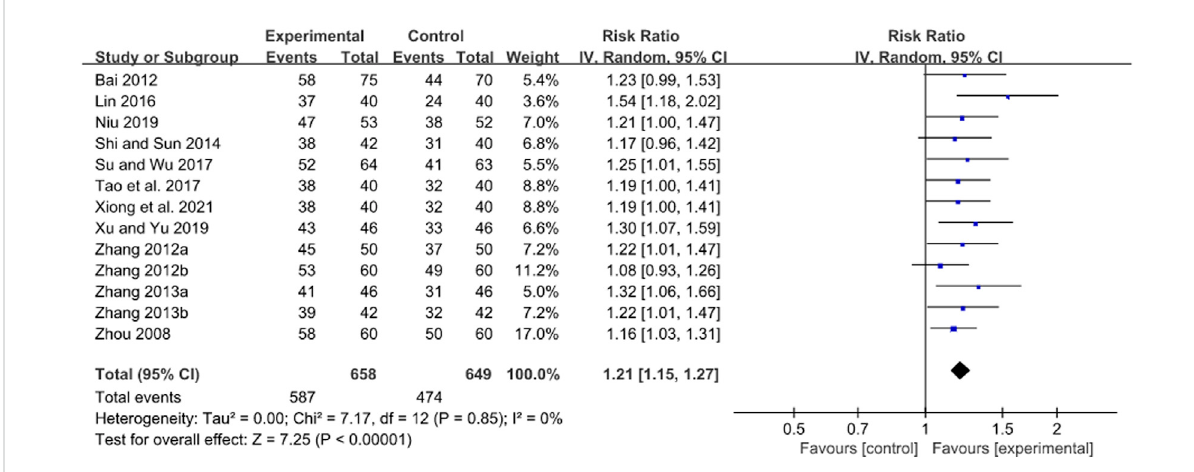
FIGURE 6 Forest plot of H. pylori eradication rate after JWC with the duration of 4 weeks.